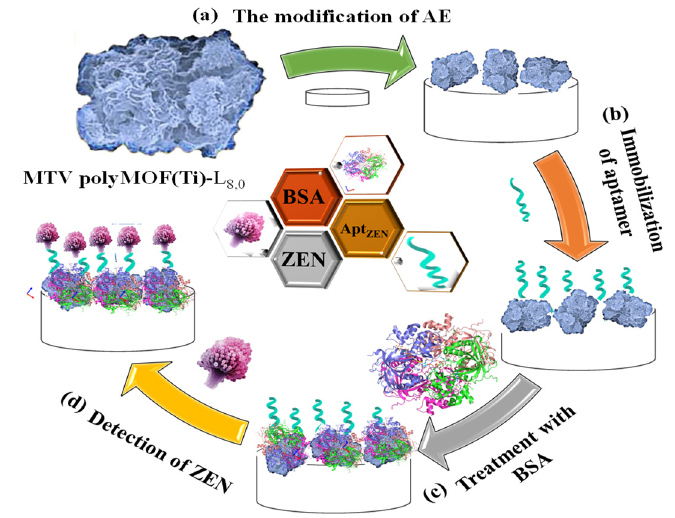
Figure 3. Graphical illustration of the stages involved in creating an aptasensor relying on MTV poly MOF-L8,0 for the sensing of zearalenone, comprising modifying the Au electrode with MTV poly MOF-L8,0, zearalenone-targeted aptamer anchoring, Apt/MTV poly MOF-L8,0/AE blocking, and zearalenone sensing utilizing bovine serum albumin (BSA)/Apt/MTV poly MOF-L8,0/AE. Adapted with permission from the article of [64]. 2022, Elsevier.